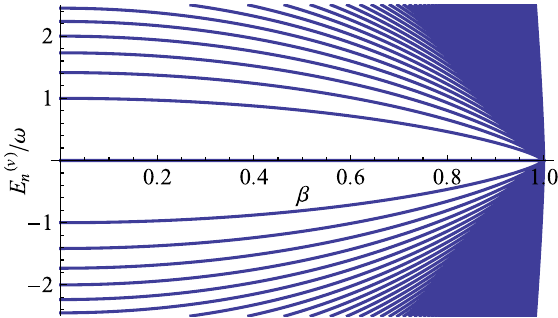
FIG. 5. Velocity dependence of the bound-state spectrum of a ffiffiffi p j / j x j and thus n ! of a static domain wall moving domain wall. The spectrum top is renormalized by a factor (cid:4) (cid:1) 3 = 2 for domain walls moving at velocity v ¼ (cid:9)u , cf. Eq. (22). The discrete domain-wall spec- trum collapses into a continuous spectrum upon reaching the effective speed of light u , where (cid:9) ! 1